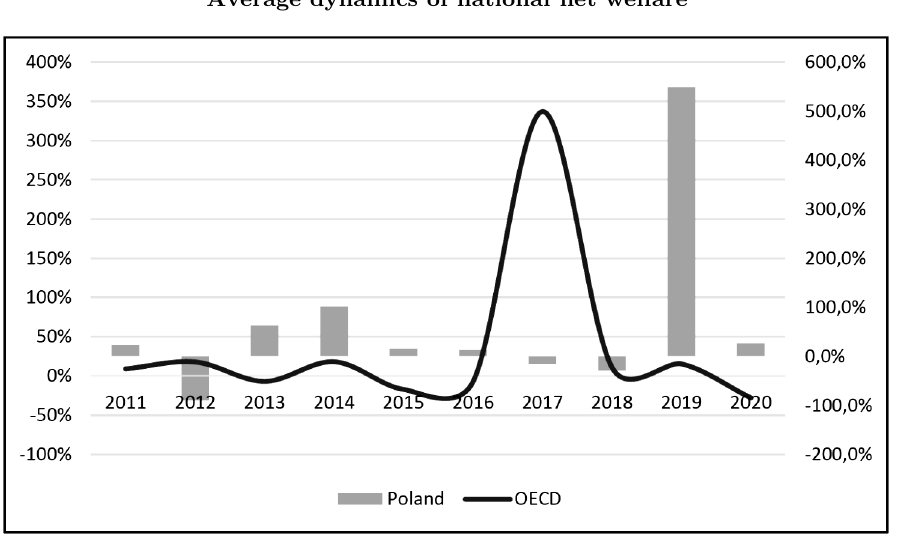
Figure 4 Average dynamics of national net welfare